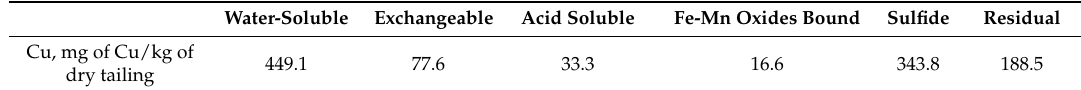
Table 1. Initial concentration of copper in each fraction.